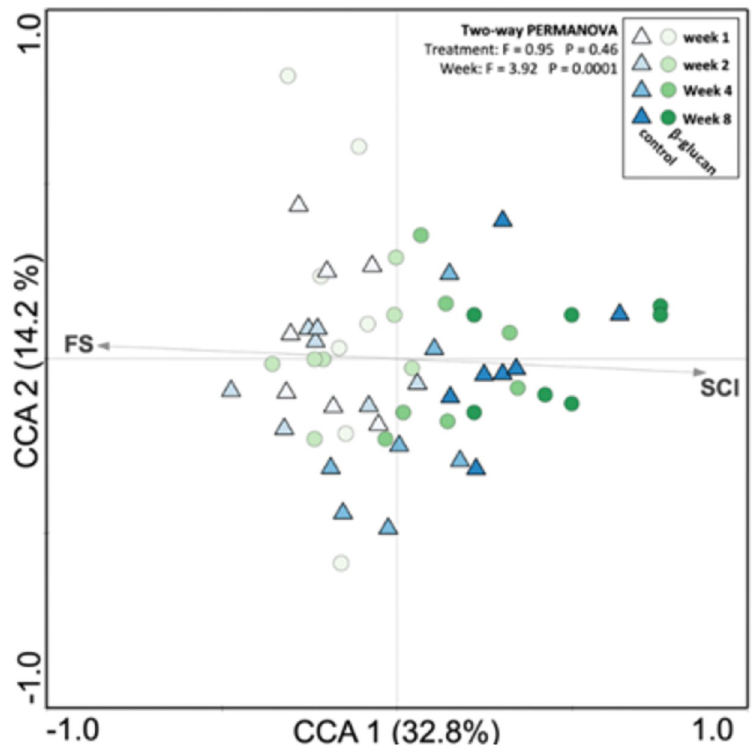
Fig 6. Correlation between dairy calves’ starter concentrate intake (SCI) and fecal score (FS) with bacterial structure. Canonical correspondence analysis of the bacterial community patterns and these two variables. Arrows indicate correlation between SCI/FS and microbial profile. Only significant parameters factor is